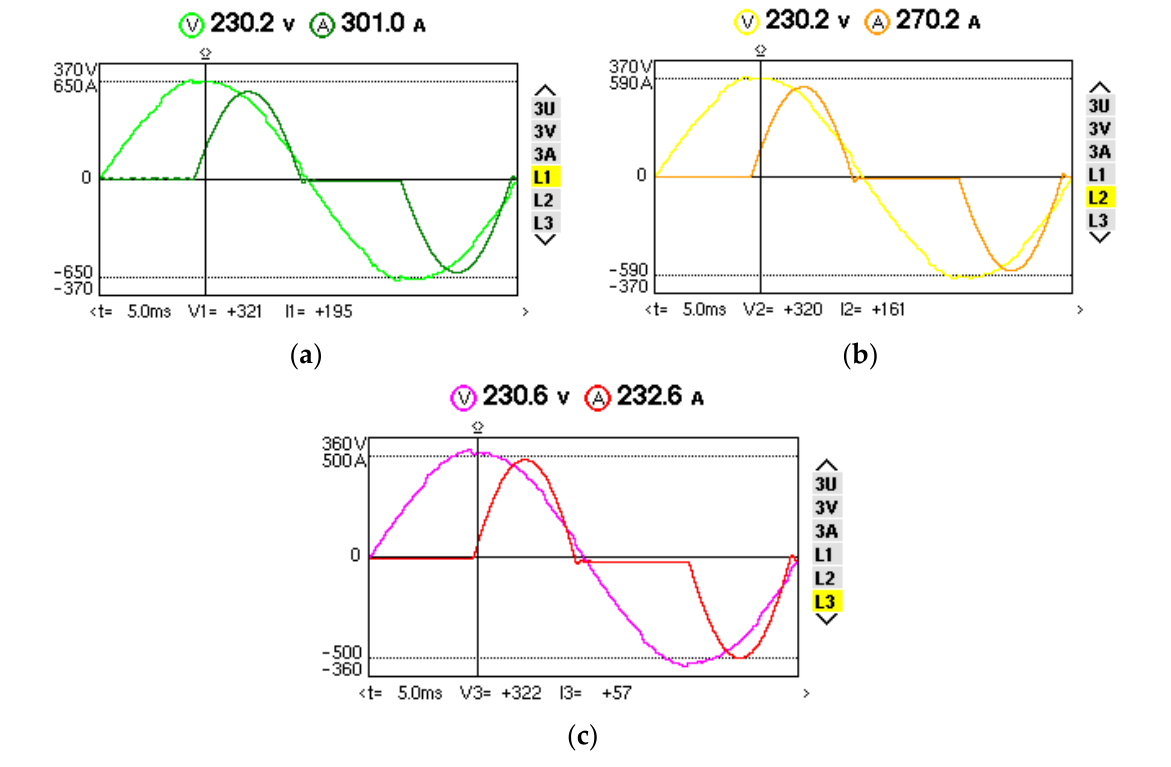
Figure 18. Phase voltages and currents (at one moment in time) for an ESP with three sections on: ( a ) L1; ( b ) L2; ( c ) L3.